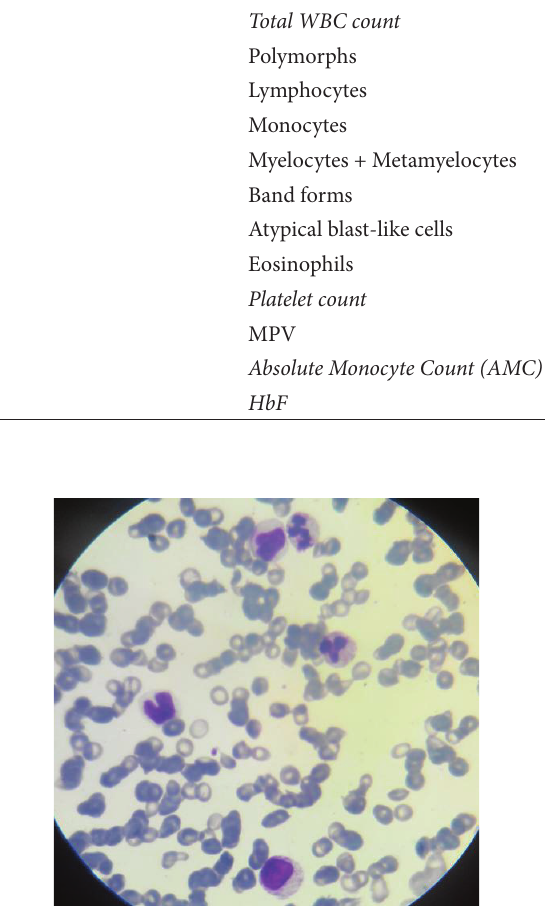
Figure 1: Peripheral smear showing monocytes, myeloid precursor, and normal sized